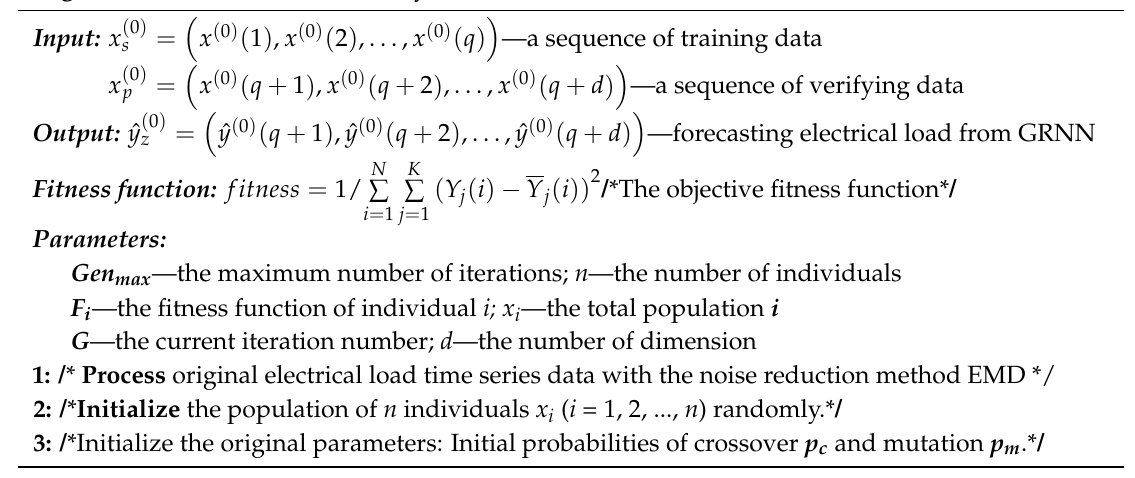
Algorithm 3: Pseudo code of the hybrid model of